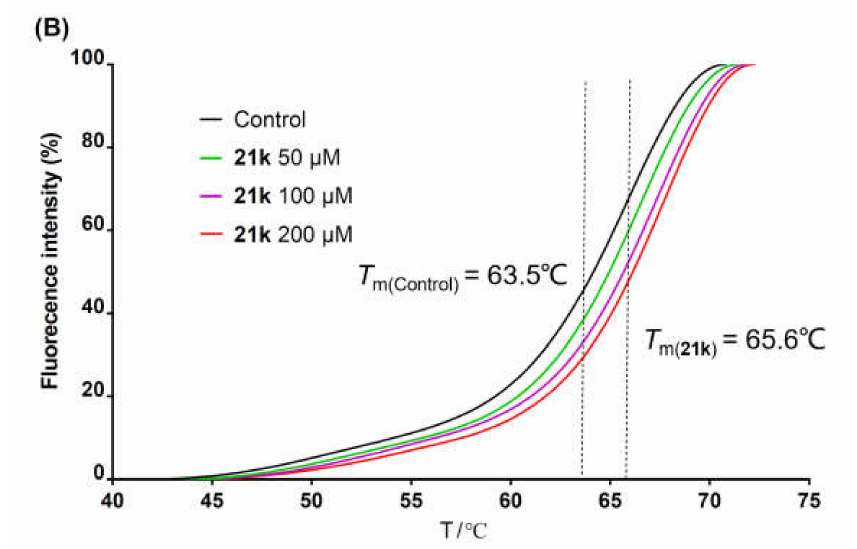
Figure 3. Fluorescence intensity change versus temperature of NS5B complexed with different concentrations of 21e ( A ) or 21k ( B ). Table 3. Thermal shifts of the melting temperatures of NS5B complexed with tested compounds.